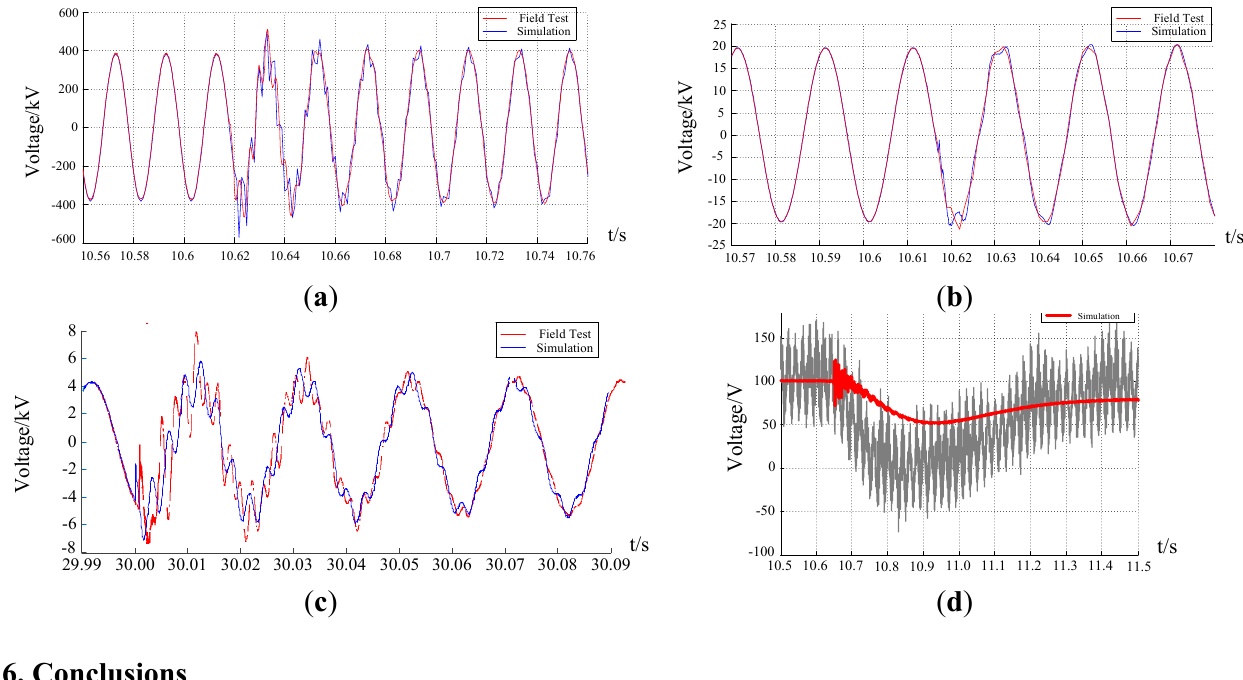
Figure 16. ( a ) Voltage waveform of the main transformer; ( b ) voltage waveform of the generator; ( c ) voltage waveform of the house load bus; and ( d ) voltage waveform of the excitation